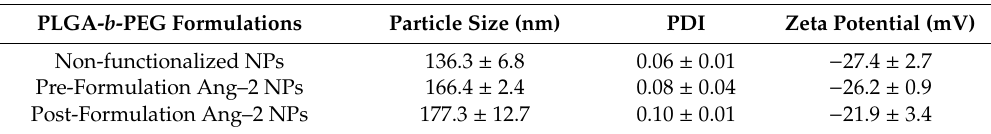
Table 2. Particle size, polydispersity index, and zeta potential of PLGA- b -PEG nanoparticles pre- and post-functionalized with